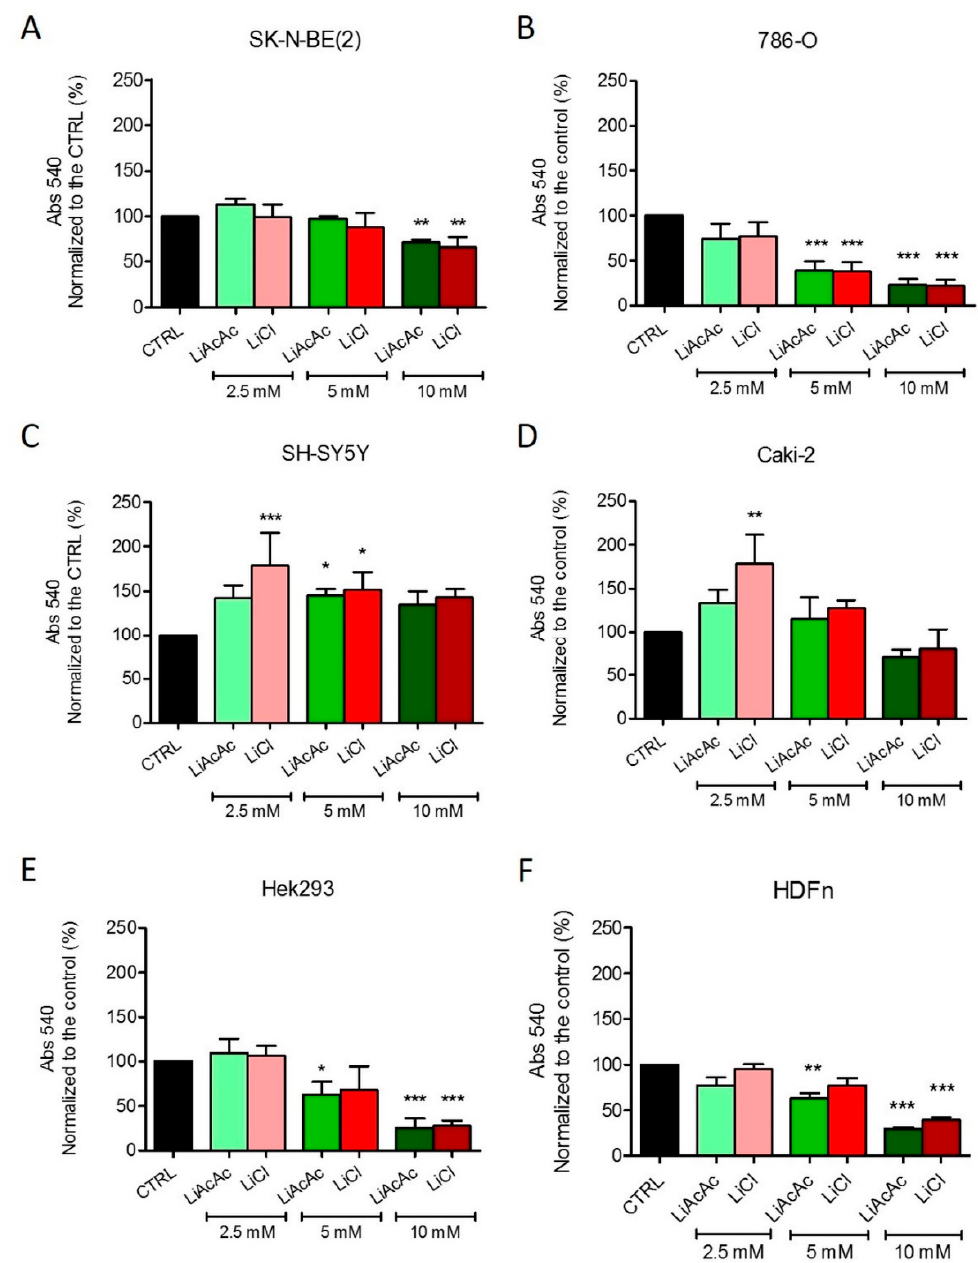
Figure 1. Growth of SK-N-BE(2) ( A ), 786-O ( B ), SH-SY5Y ( C ), CAKI-2 ( D ), HEK293 ( E ), and HDFn ( F ) cells treated with 2.5 mM, 5 mM, and 10 mM LiAcAc or LiCl. Data are given as mean ± SD. Statistical analysis was performed by using one-way ANOVA (Dunnett’s Multiple Comparison Test); treatments vs. control: * p < 0.05, ** p < 0.01, *** p < 0.001; n = 3 independent experiments (6 wells / treatment /